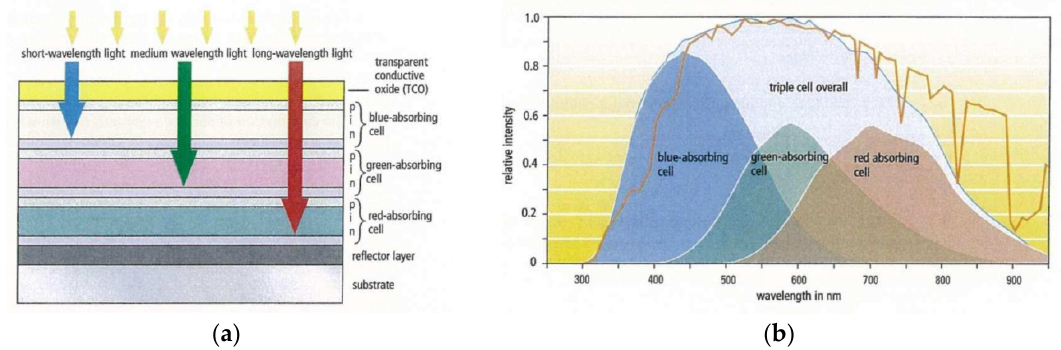
Figure 9. An amorphous triple solar cell with its configuration ( a ) and spectral responses ( b ) [38].